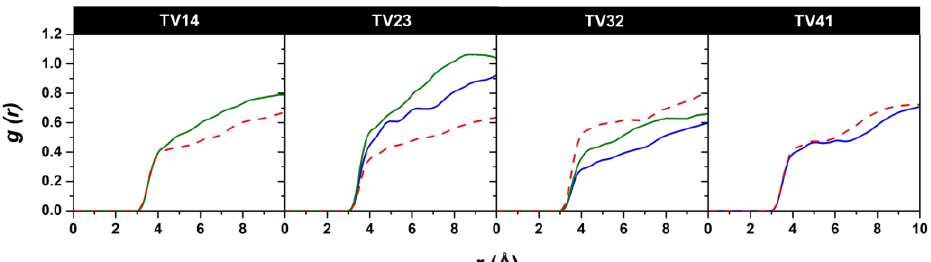
Figure 7. The site – site RDFs of CA – CA atom pairs between the polymer benzene rings of four stud- ied PET/PET blends.